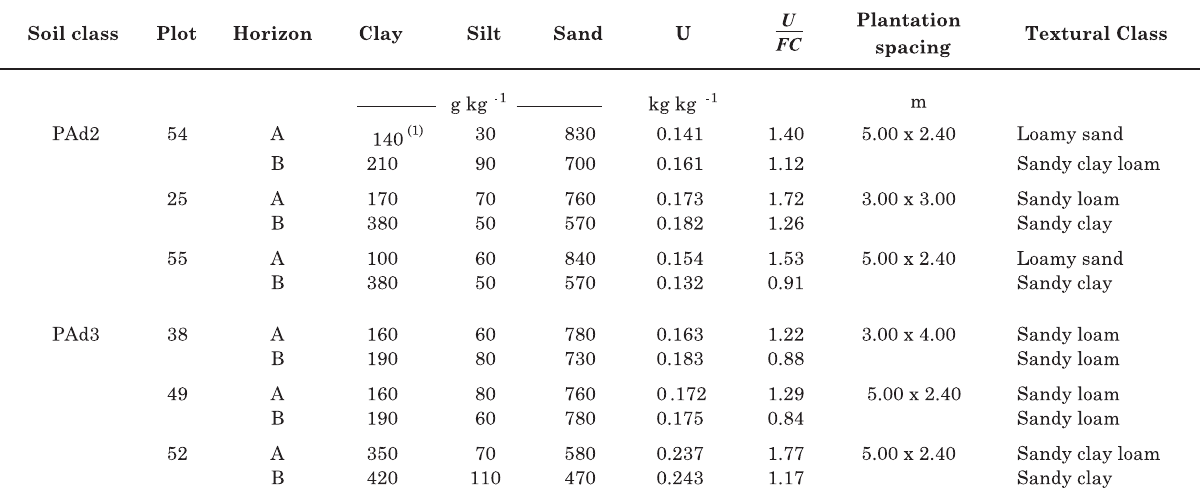
Table 1. Physical characteristics of the PAd2 and the PAd3 soil